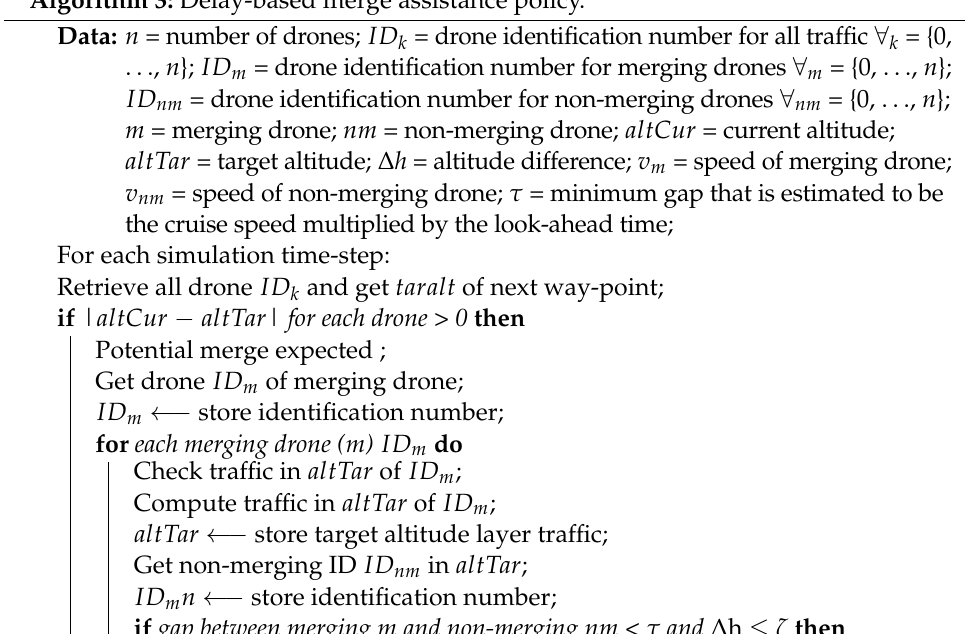
Algorithm 3: Delay-based merge assistance